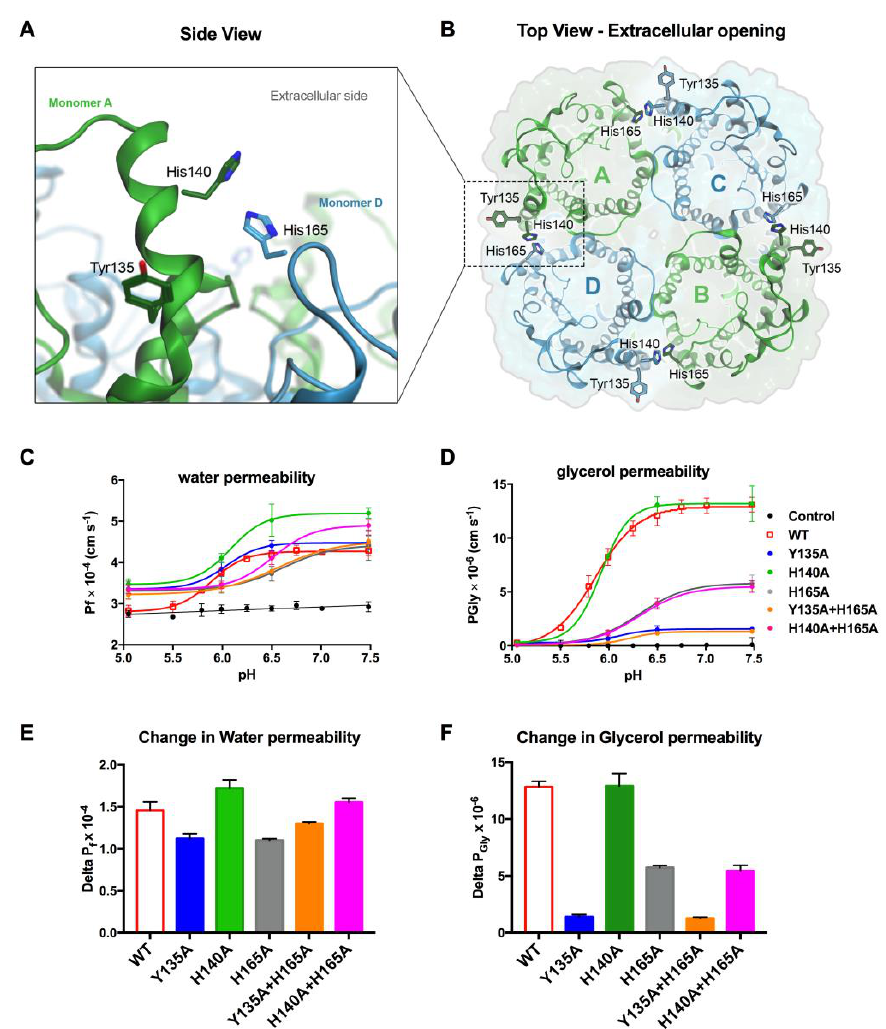
Figure 5. Putative residues involved in hAQP7 pH regulation. ( A ) Side and ( B ) top views of the refined homology model of human AQP7 in its tetrameric assembly, in cartoon representation of the tertiary structure, with ribbon representation of each monomer. Amino acid residues are shown in stick representation and backbone and hydrogens are hidden for clarity. Residues are colored according to the corresponding monomer, as shown in B. Figure generated with MOE [45]. ( C ) Water permeability ( P f ) and ( D ) glycerol permeability ( P Gly ), measured at pH 5.0 to 7.5, of control cells and cells expressing hAQP7-WT and -mutants. ( E ) Magnitude of the change in water (Delta Pf) and in ( F ) glycerol (Delta PGly) permeability (from pH 7.4 to pH 5.0) due to point mutations. All permeability assays were performed at 23 °C. Data (mean ± SEM, n = 4 for each data set) were fitted according to the Hill equation.